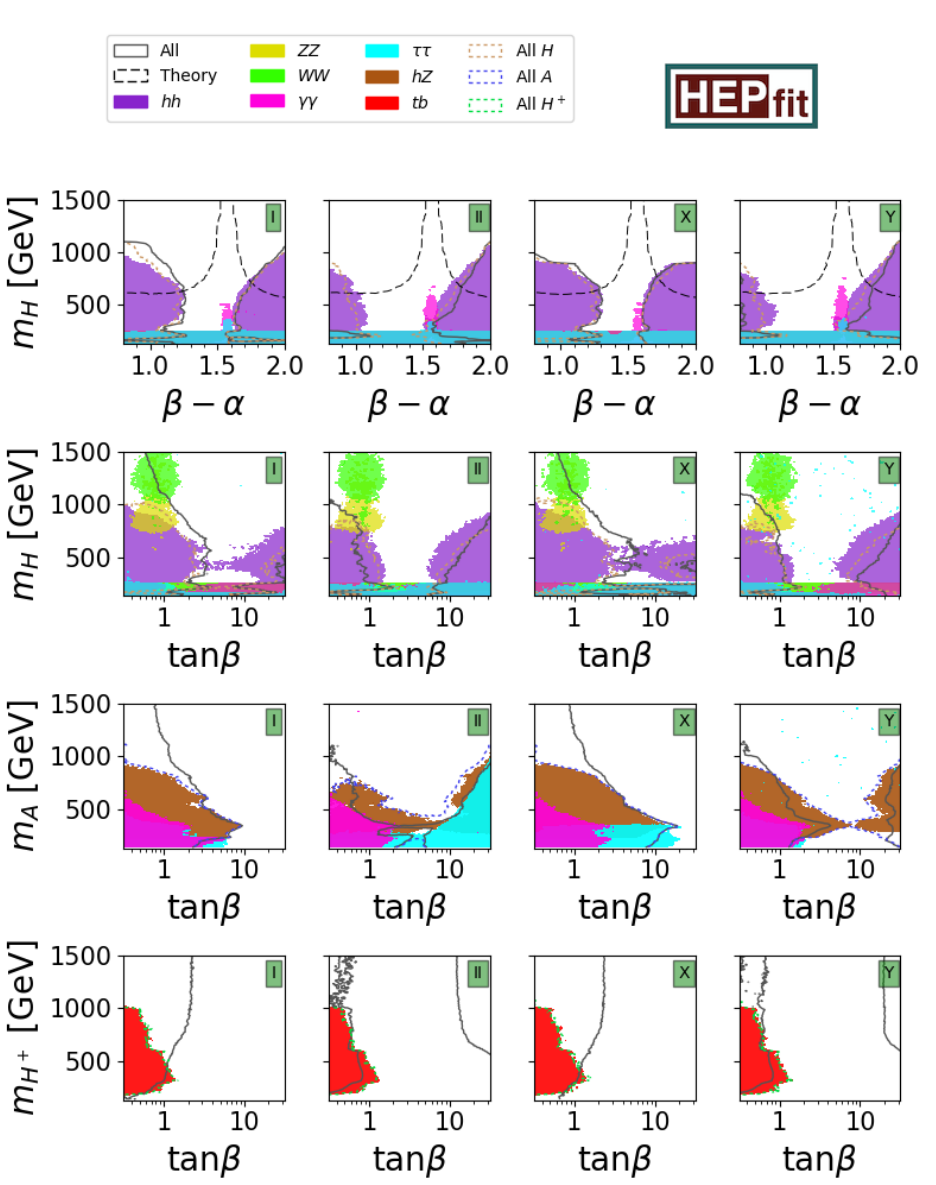
Figure 3 . In the 2HDM masses vs. angles planes we display the regions excluded by all heavy Higgs searches with a probability of 95.4% by the central area inside the grey solid line. We compare them with the areas excluded by searches in various (cid:12)nal states represented by the coloured patches. The areas inside the coloured dashed lines correspond to the exclusion at 95.4% when all H searches (orange), all A searches (dark blue) and all H + searches (dark green) are considered. In the (cid:12)rst row the limits from theory constraints are shown by black dashed